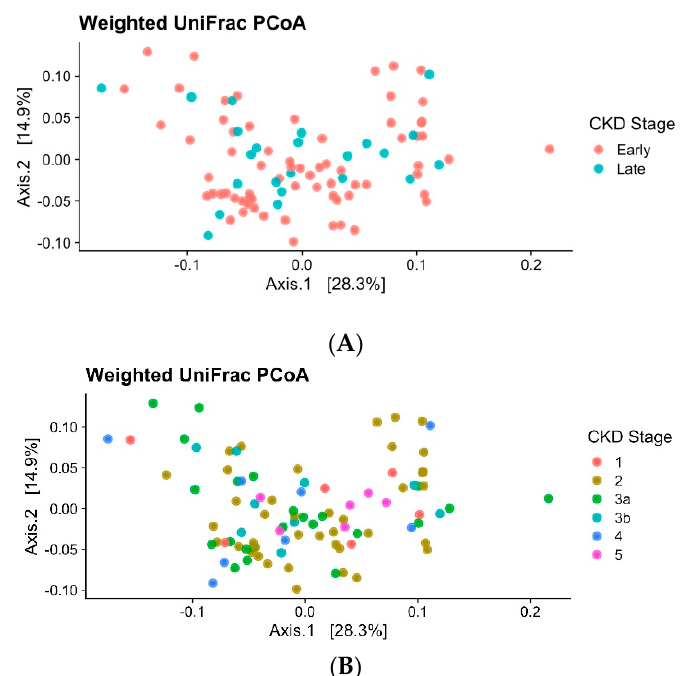
Figure 2. ( A ) Principal coordinate analysis (PCoA): Ordination plots display the dissimilarity of the gut bacterial community from individuals with CKD. Plots are labelled to show CKD grouped into classifications of early (1 to 3a) and late (3b to 5) stages. Data were based on weighted UniFrac of log-transformed relative abundances. ( B) Ordination plots display the dissimilarity of the gut bacterial community from individuals with CKD. Plots are labelled to show CKD at fine-scale groups. Data were based on weighted UniFrac of log-transformed relative abundances. within the microbial community samples. The Shannon index considers both the species